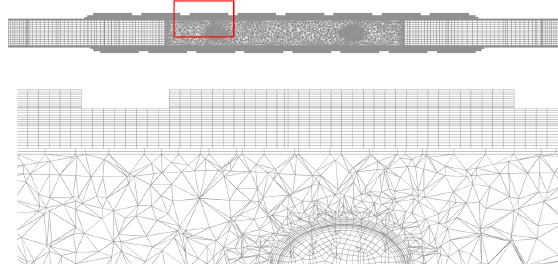
Figure 6 . Detailed to boundary layer mesh of the tube.